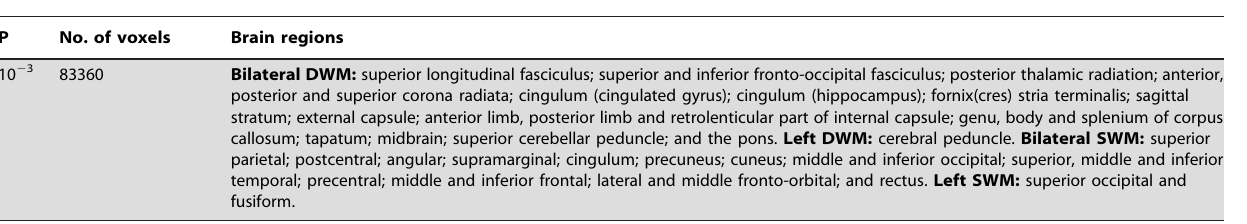
Table 2. Brain regions with negative correlation between white matter volume and the number of optic neuritis attacks.